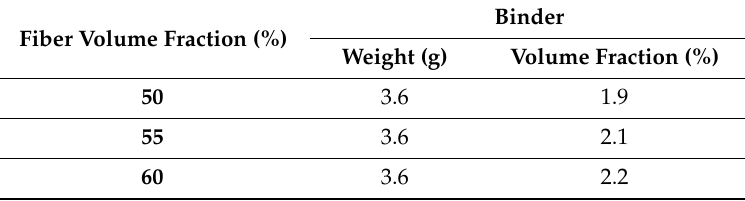
Figure 2. Schematic of the permeability measurement system. Table 1. Binder content in the fabric preform specimen in each fiber volume